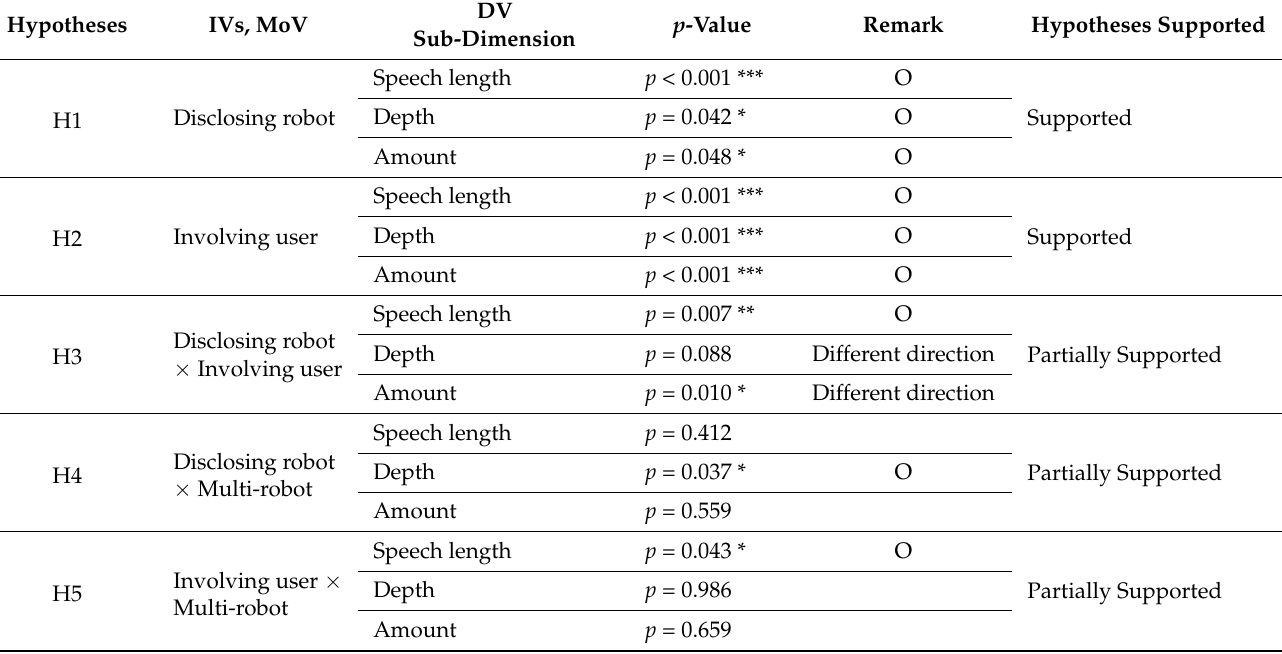
Table 7. Summary of